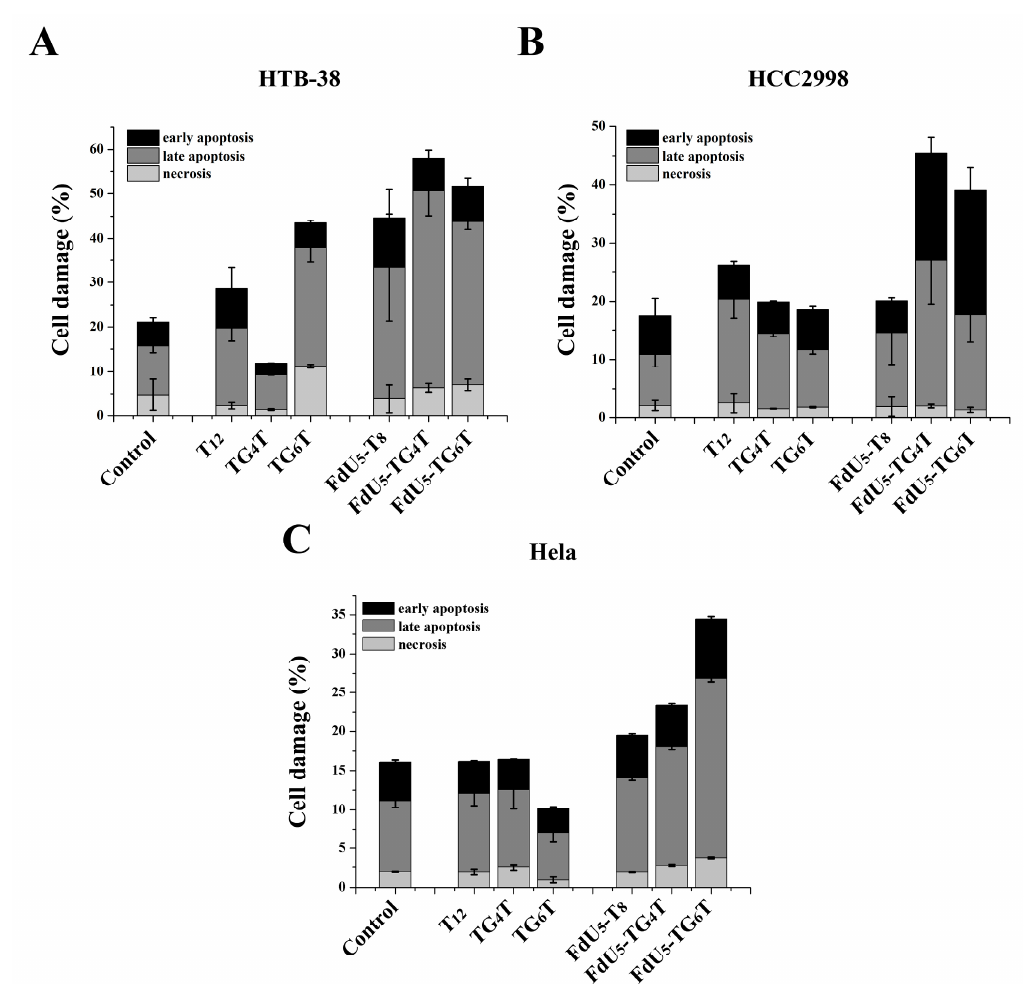
Figure 4. Apoptosis assay comparing TG 4 T and TG 6 T along or carrying 5 molecules of FdU, in ( A ), HeLa ( B ), HTB-38 and ( C ), HCC2998. Error bars represent the standard deviation (SD) of two independent experiments in duplicate. In comparison, the formation of an extra tetrad in TG 6 T favors cell damage in HeLa cells producing a distinguished behavior between the two G-quadruplexes as also shown in MTT assay. HCC2998 cells, conversely, do not present a difference in the actions of the